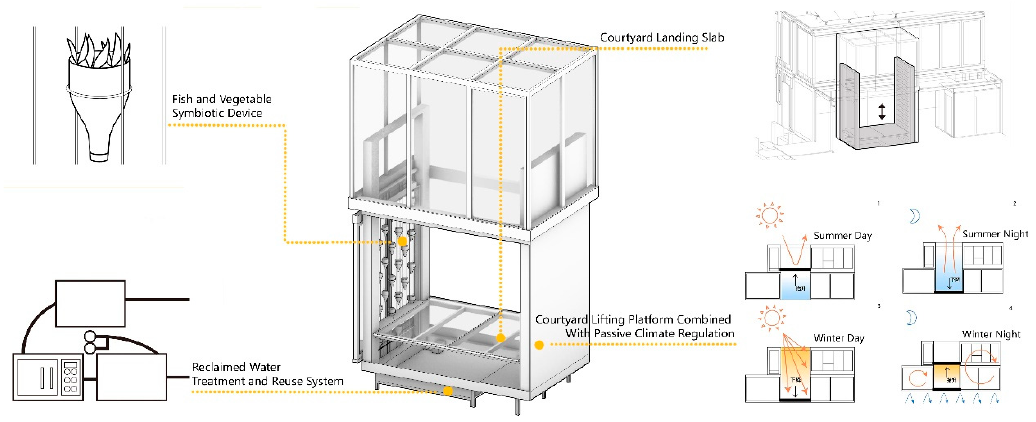
Figure 6. Elevated courtyard combined with passive climate regulation .